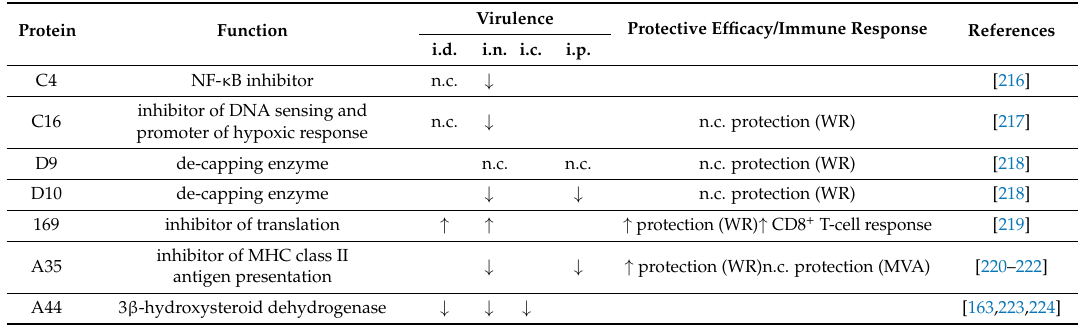
Table 4. VACV strains lacking other intracellular immunomodulators that have been tested for virulence and/or immunogenicity.